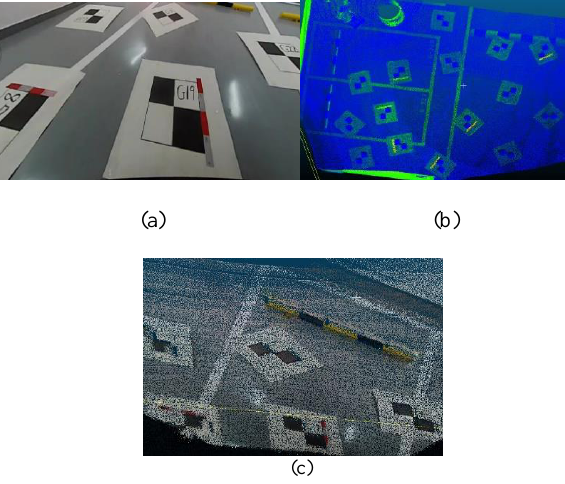
Figure 3. Correspondent data from multi-sensor. (a) Corrected fisheye lens camera image. (b) 3D point cloud acquired. (c) Fusion